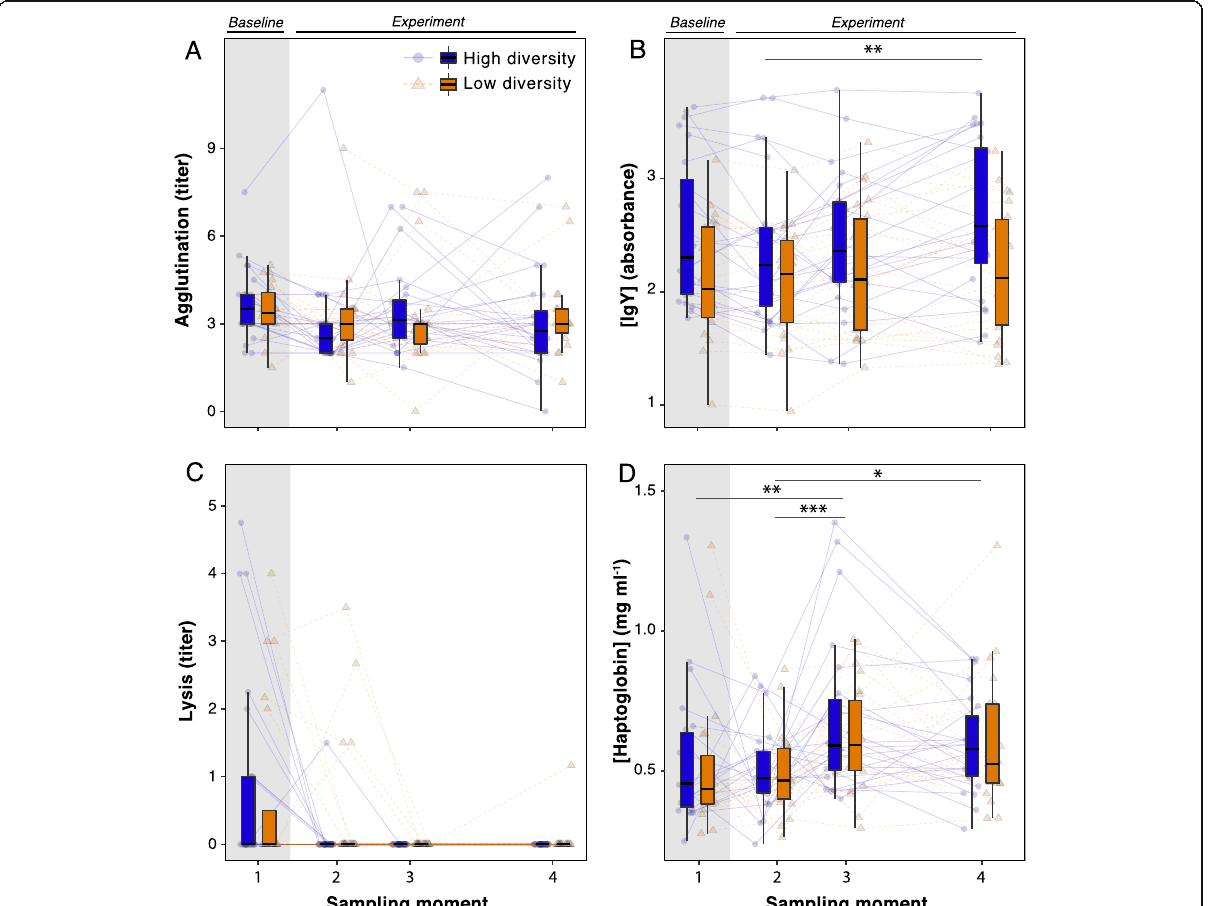
Fig. 1 Experimental and temporal effects on host immune function. Relationships of population-level variation of ( a ) agglutination titer, ( b ) IgY concentration, ( c ) lysis titer and ( d ) haptoglobin concentration across sampling moments, stratified by experimental treatment. Faded blue circles (high diversity soil) and orange triangles (low diversity soil) represent individual measurements connected by a line per individual female (solid = high diversity, dashed =low diversity). Boxplots show median and first and third quartile per group, with whiskers representing 1.5 · IQR. Treatment groups were measured simultaneously but split along x-axis for visual clarity. Grey area highlights the baseline sampling moment. Experimental treatment and temporal effects on lysis titer were analyzed as occurrence of lytic activity. Asterisks above plots denote pairwise contrasts among sampling moments; * FDR-corrected q <0.1, ** q <0.01. Statistics are detailed in Table 1. The experimental effect on IgY concentration is also significant after exclusion of baseline samples ( F =4.35, P